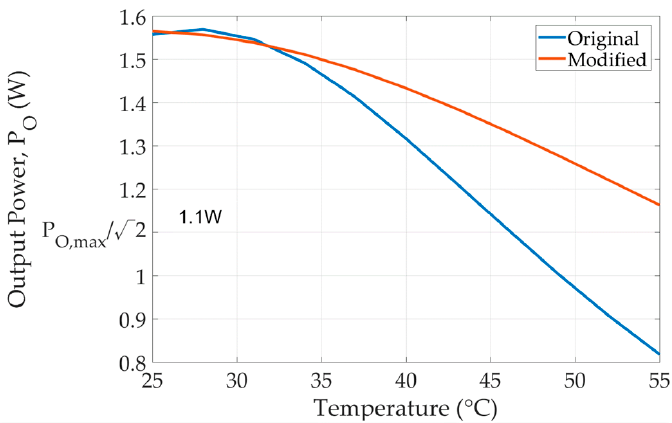
Figure 12. Comparison of the output power P O in the original circuit and that in the circuit modified by adding series resistance and adjusting capacitance in the LCC resonant circuit.